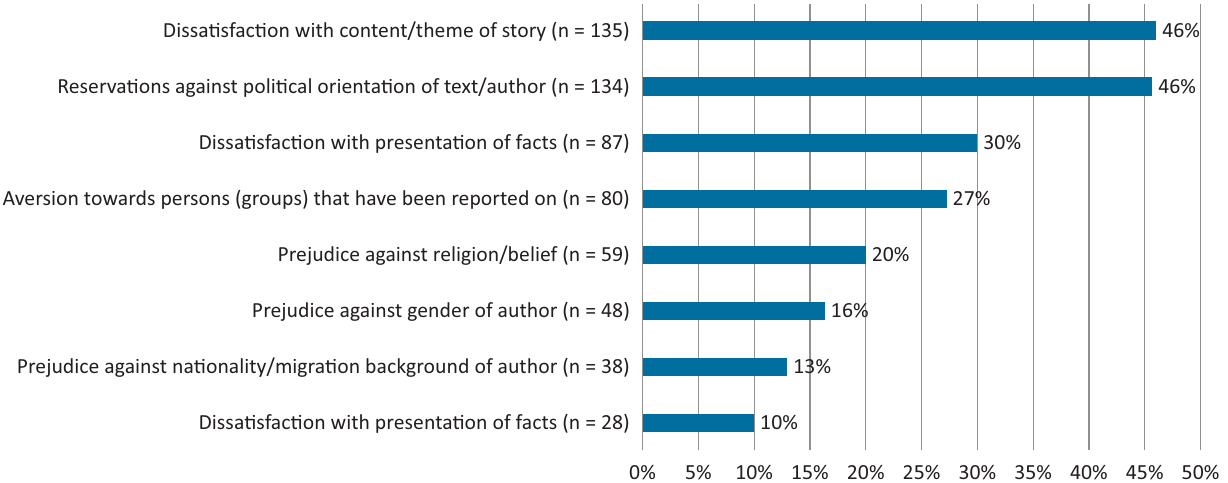
Figure 1. (Assumed) causes for harassment (n = 273, only respondents with assault experience). Source: Author. Table 3. Consequences of harassment.